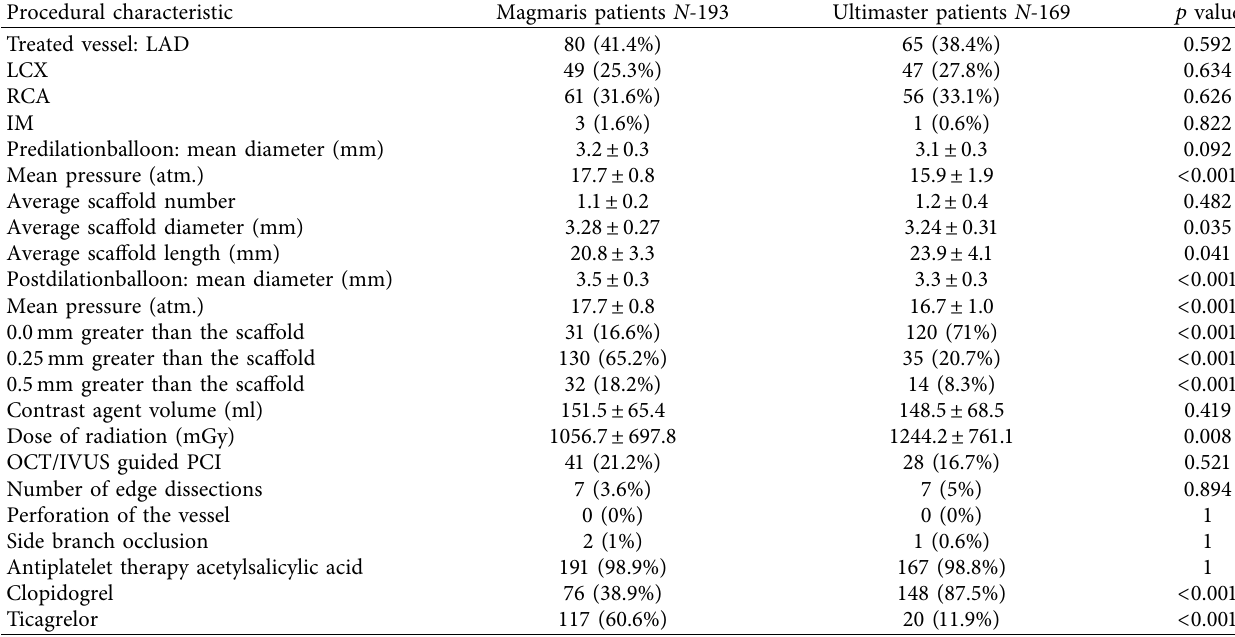
Table 2: Procedural